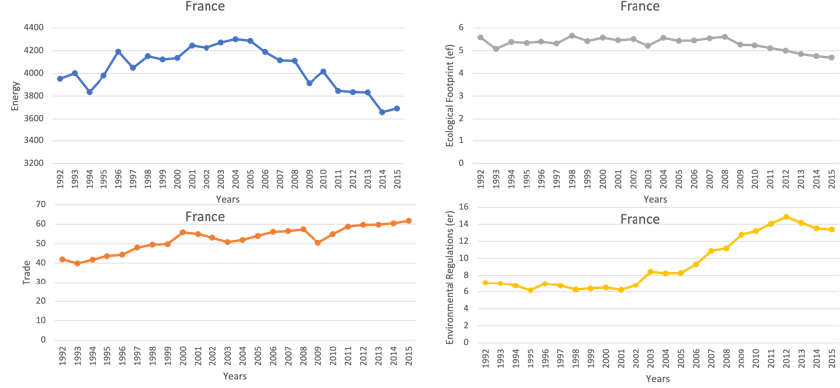
Figure 1. Data visualization for France.